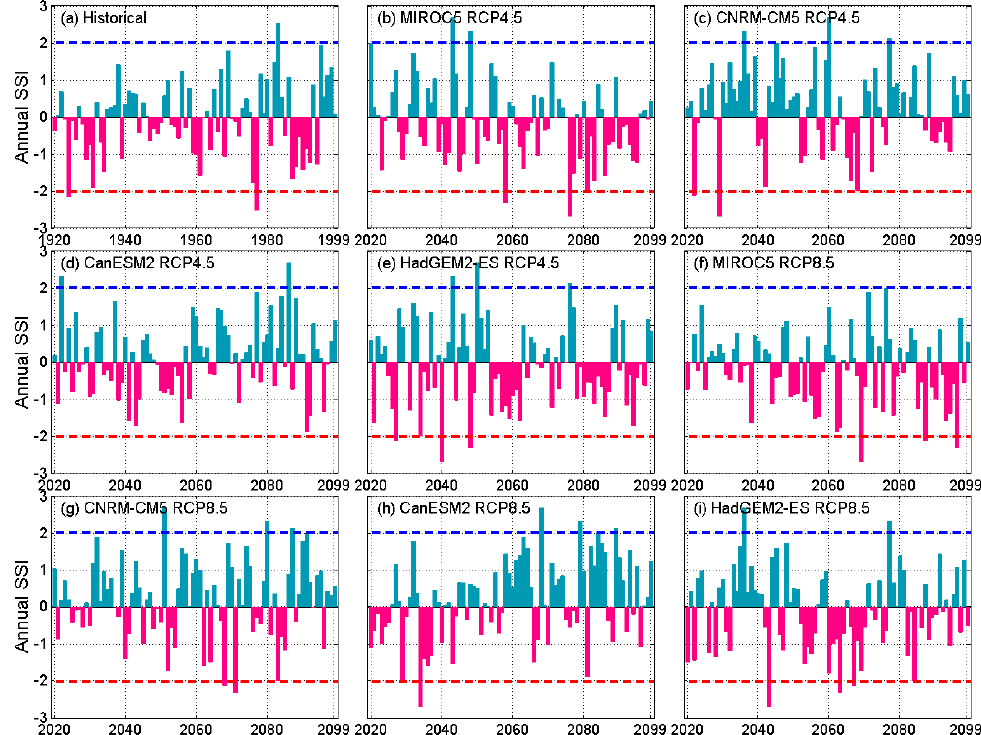
Figure A6. Historical and projected annual SSI for SJQ4. Values above the blue dash line represent extremely wet conditions while values below the red dash line indicate extremely dry conditions. Table A2. Mean and variance of seasonal and annual SSI indices.